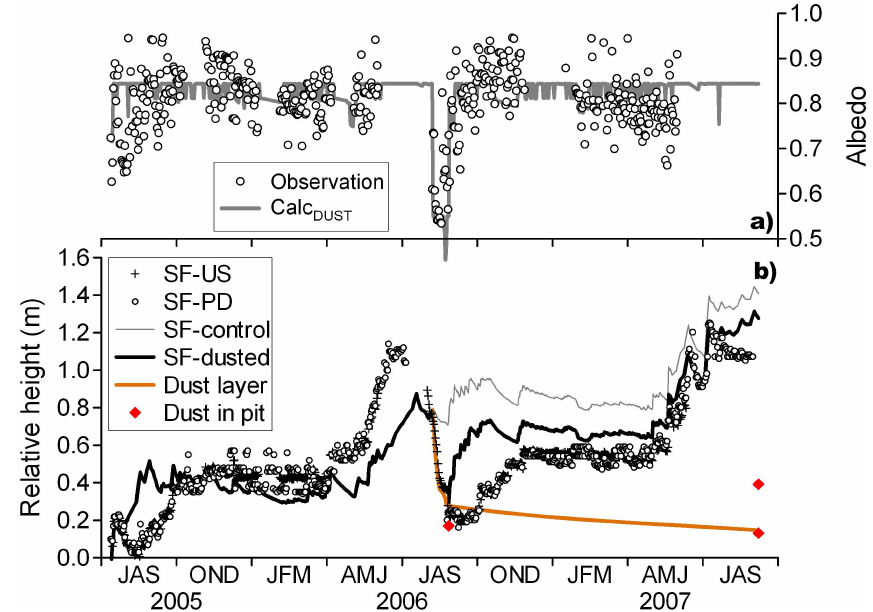
Fig. 5. Albedo (a) and relative surface height (b) at the summit of the Gregoriev Glacier from July 2005 to September 2007. Circles and the thick grey line in (a) denote observed and calculated albedos (dusted run). Symbols in (b) denote surface levels measured by an ultrasonic sensor (crosses, SF-US) and by a photo-diode sensor (circles, SF-PD). Lines in (b) denote calculated surface levels in the control run (thin grey line, SF-control), dust run (thick black line, SF-dusted), and the modelled dust layer tracked in the snow layer (thick brown line, Dust layer). The calculated surface levels overlap for the first year. Also shown are the dust layers observed in the snow pits excavated in 2006 and 2007 (red diamonds).